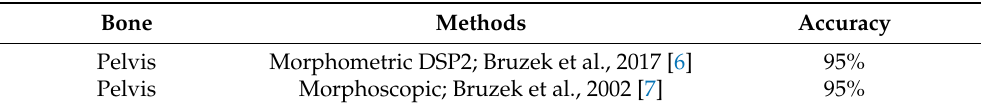
Table 1. Accuracy of sex estimation method using morphological and metric methodologies. Bone Methods Accuracy Pelvis